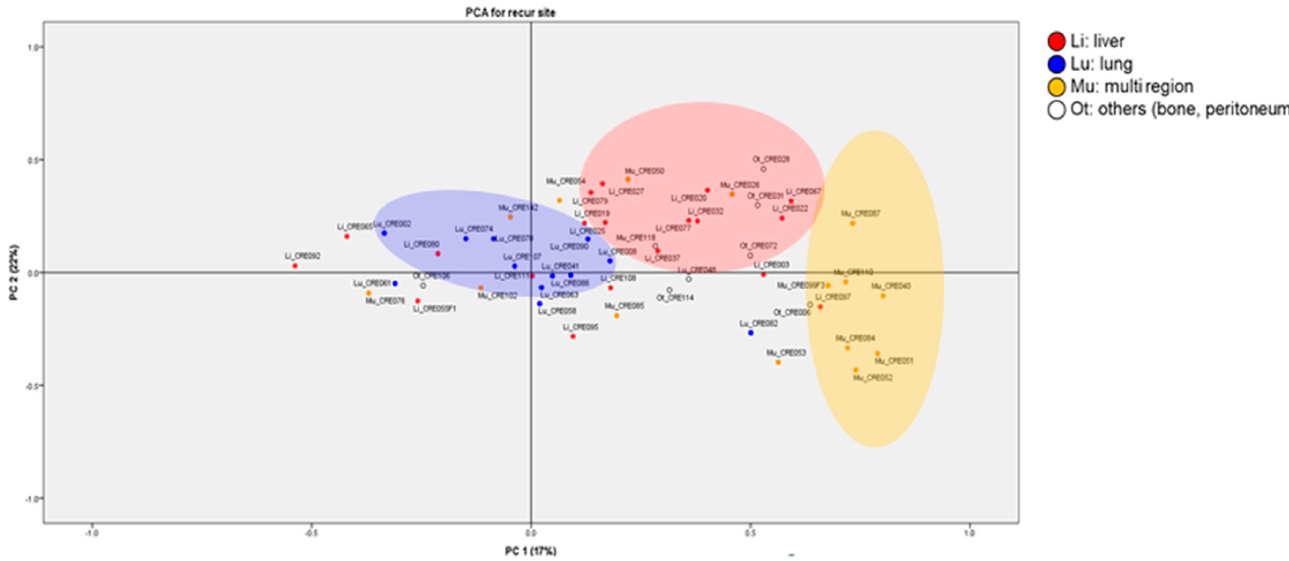
Figure 3. The principal component analysis (PCA) based on detected exosomal RNA levels.